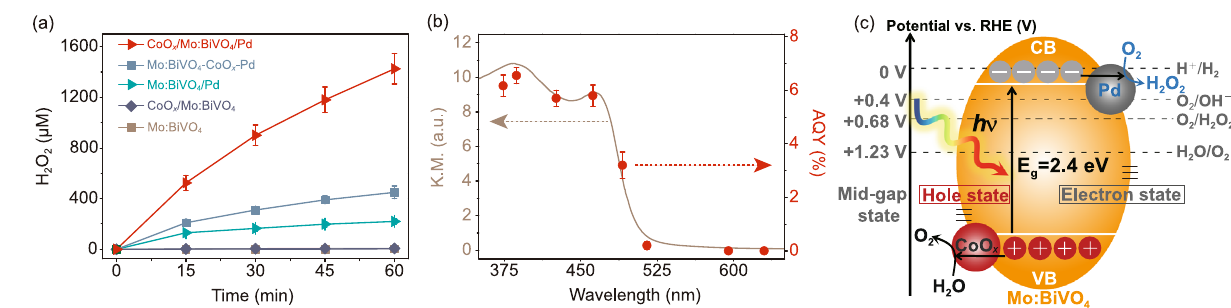
Fig. 2 Photocatalytic H 2 O 2 generation activities. a Time courses of photocatalytic H 2 O 2 generation over CoO x /Mo:BiVO 4 /Pd, Mo:BiVO 4 -CoO x -Pd, CoO x /Mo:BiVO 4 , Mo:BiVO 4 /Pd, and Mo:BiVO 4 . Reaction conditions: photocatalyst amount, 2 mg; reactant solution, 12 mL PBS aqueous solution (pH = 7.4) saturated with O 2 ; light source, xenon lamp solar simulator, 100 mW/cm 2 , AM 1.5 G. We note the data series for CoO x /Mo:BiVO 4 (7.5 μ M at the reaction time of 60 min) overlap with those of Mo:BiVO 4 (4.1 μ M at the reaction time of 60 min). b Apparent quantum yield (AQY) of photocatalytic H 2 O 2 generation over CoO x /Mo:BiVO 4 /Pd as a function of the incident light wavelength. Reaction conditions: photocatalyst amount, 2 mg; reactant solution, 5 mL PBS aqueous solution (pH = 7.4) saturated with O 2 ; light source, monochromatic LED light. c Schematic of photocatalytic H 2 O 2 generation over CoO x /Mo:BiVO 4 /Pd. CB and VB are short for conduction band and valence